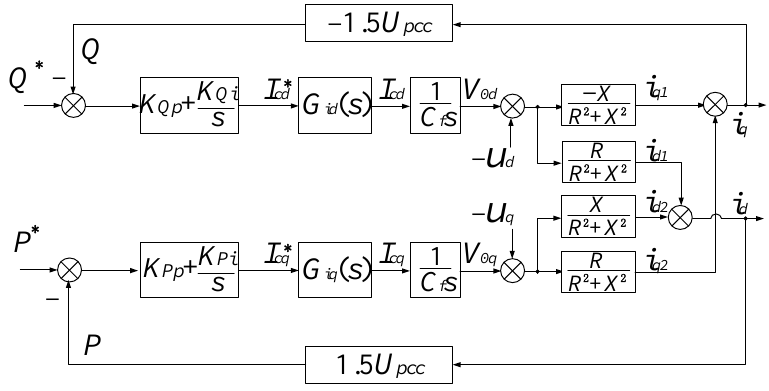
Figure 5. Block diagram for PQ ( real and reactive power ) control.